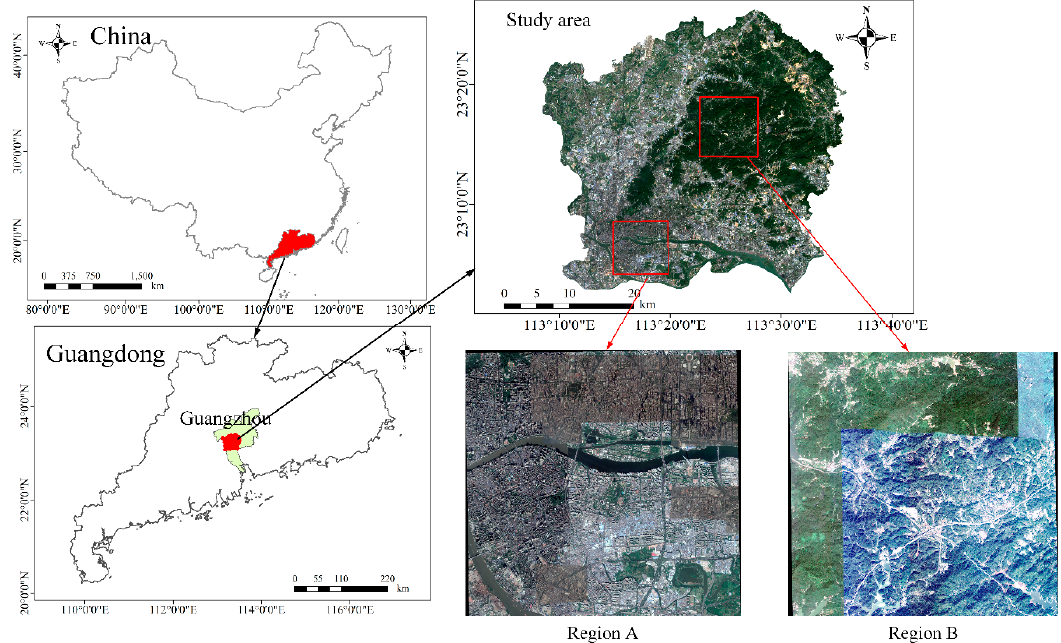
Figure 1. RGB (R: band 4, G: band 3, B: band 2) images of the study areas from Sentinel-2A.